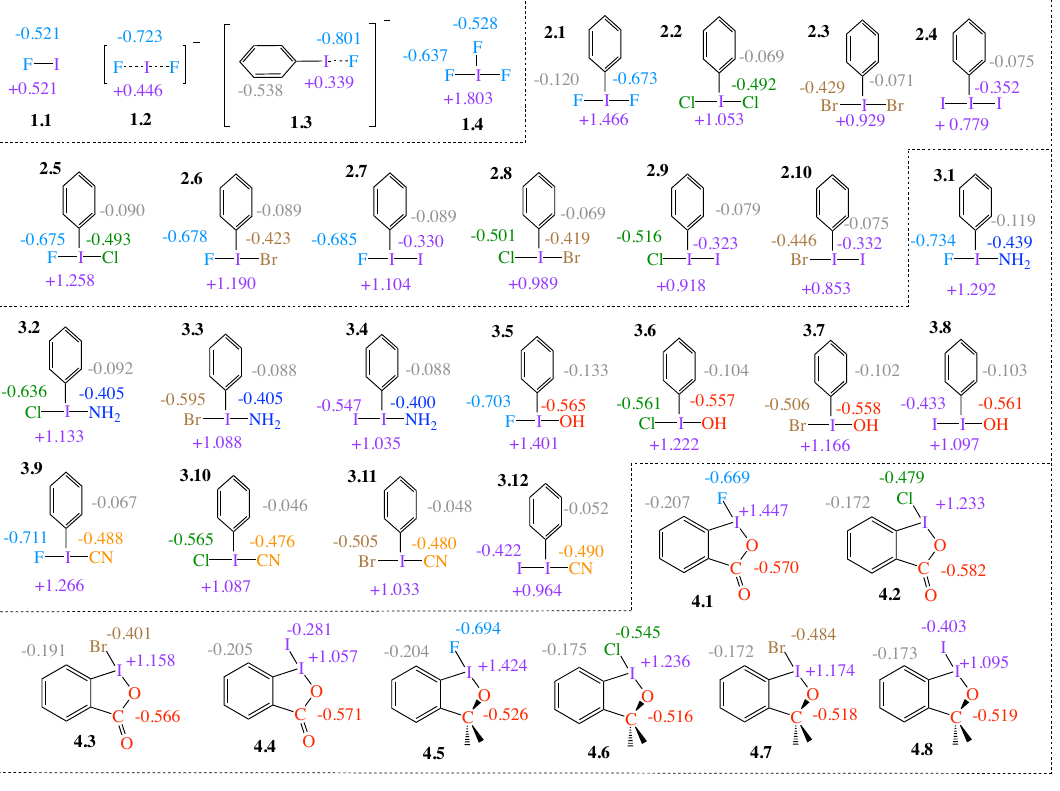
Figure 1. Schematic of the 34 molecules investigated showing the numbering system (group.molecule, e.g., 1.1–4.8 ) given in bold face, and natural bond orbital (NBO) charges calculated at the ω B97X-D/aug-cc-pVTZ level of theory. Note: charges in grey, blue, red, and orange are Ph/benzene, NH 2 , OH, OCO (red), OC(CH 3 ) 2 (red), and CN group charges, respectively, and not atomic